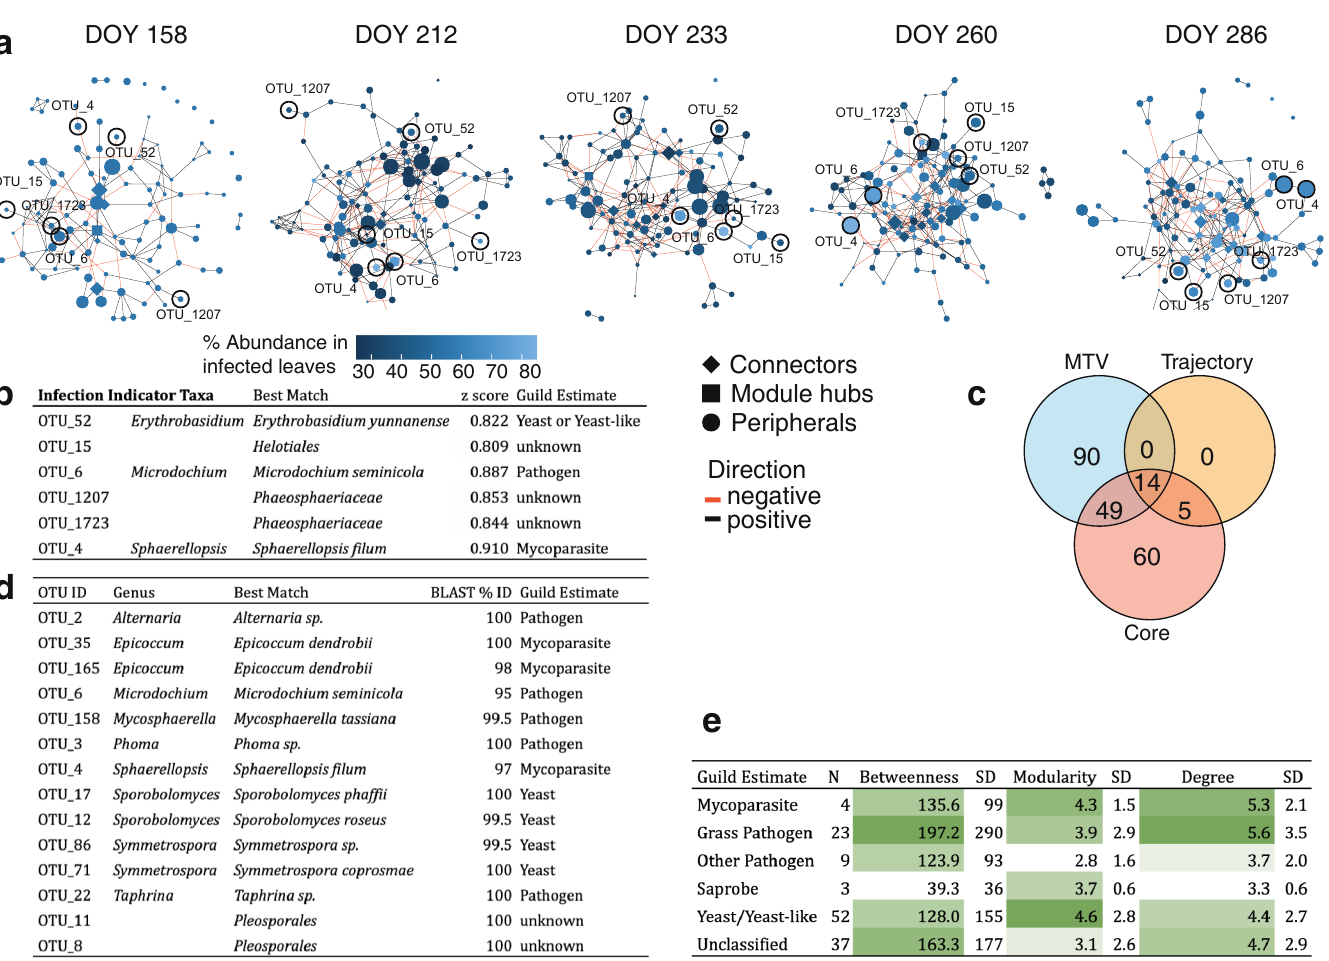
Fig 5. Network analysis of core OTUs. (A) Covariance networks of core OTUs over time. Nodes are colored by each OTU’s relative abundance in infected leaves with visible symptoms. The shape of the node denotes network position, defined by Zi-Pi ratio. Edges are colored by the covariance sign. (B) Infection indicator taxa, including best taxonomic match and z-score for indicator analysis. (C) Number of OTUs identified as important by several methods: MTV-LMM analyses that indicate time- dependent OTUs, OTUs that impact the successional trajectory, and core OTUs with high occupancy-abundance. (D) Taxonomic information for the 14 OTUs identified in all 3 analyses in (C). Best match denotes the lowest taxonomic level confidently identified for each OTU using BLAST. Guilds were estimated based on published studies, references are in S1 Table. (E) Network statistics for fungal guilds, calculated as mean values across all time points, with (SD. Data underlying this figure can be found in S5 Data. DOY, day of year; MTV-LMM, microbial temporal variability mixed linear model; OTU, operational taxonomic unit; SD, standard deviation.